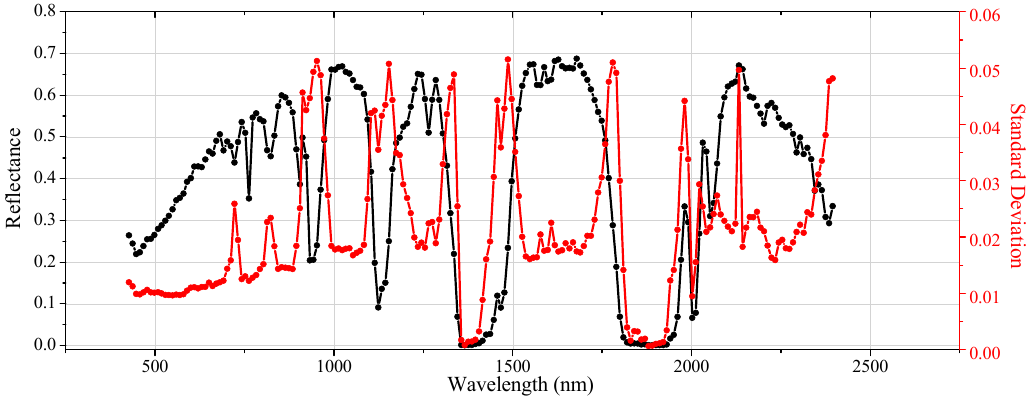
Figure 5. Average TOA reflectance profile of 224 EO-1 Hyperion images over Libya-4 from 2004 to 2014.